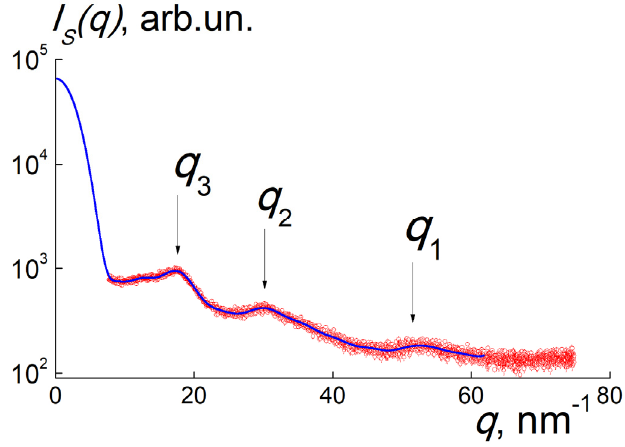
Figure 3. Intensity of X-ray scattering I(q) on pyrolyzate (red dots) vs. scattering vector modulus. The positions of peaks ( q 1,2,3 ) are marked. Solid curve (blue) corresponds to the data approximation using correlation spectrum G(R).